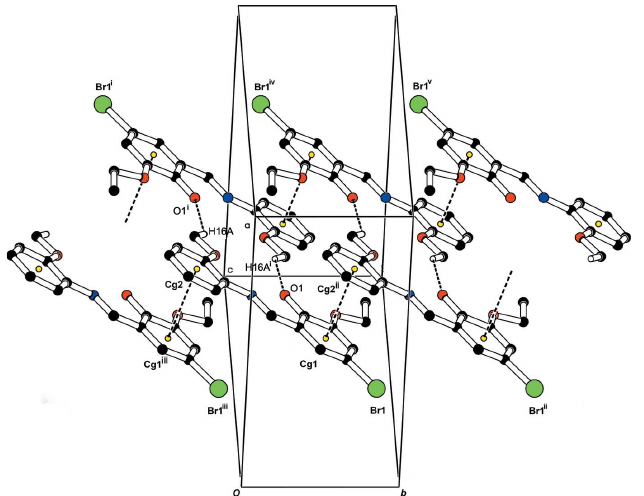
Figure 2 View of the inversion dimers, which are connected by (cid:2) – (cid:2) interactions, propagating along the c- axis direction. [Symmetry codes: (i) (cid:4) x + 1, (cid:4) y , (cid:4) z + 1; (ii) x , y + 1, z ; (iii) x , y (cid:4) 1, z ; (iv) (cid:4) x + 1, (cid:4) y + 1, (cid:4) z + 1; (v) (cid:4) x + 1, (cid:4) y + 2, (cid:4) z + 1.]